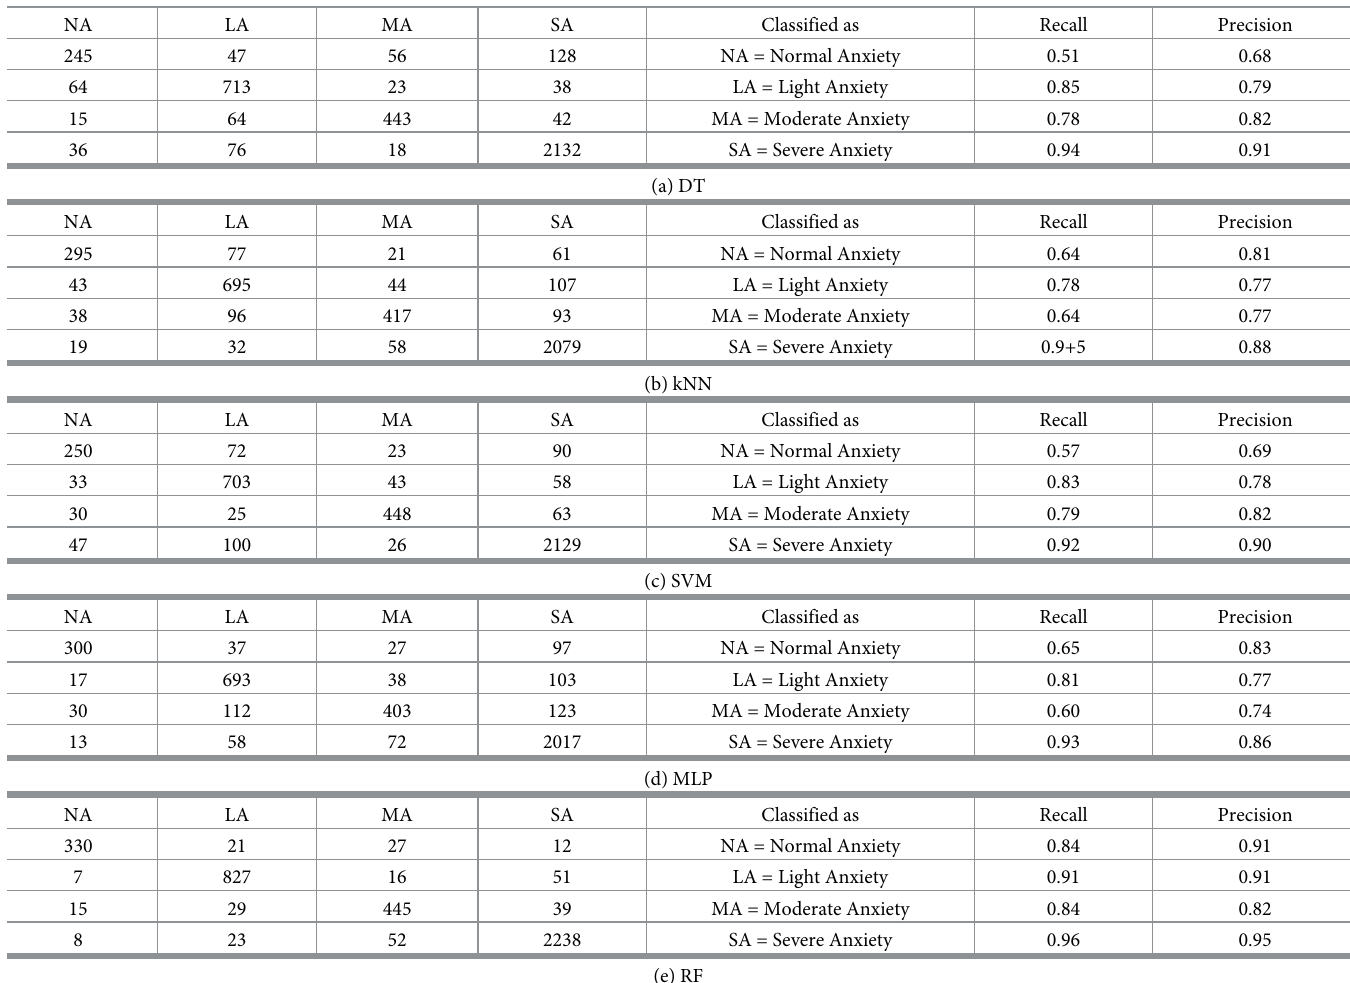
Table 5. Confusion matrix for four level anxiety classification for DT, k-NN, SVM, MLP and RF classifier using HAM-A based